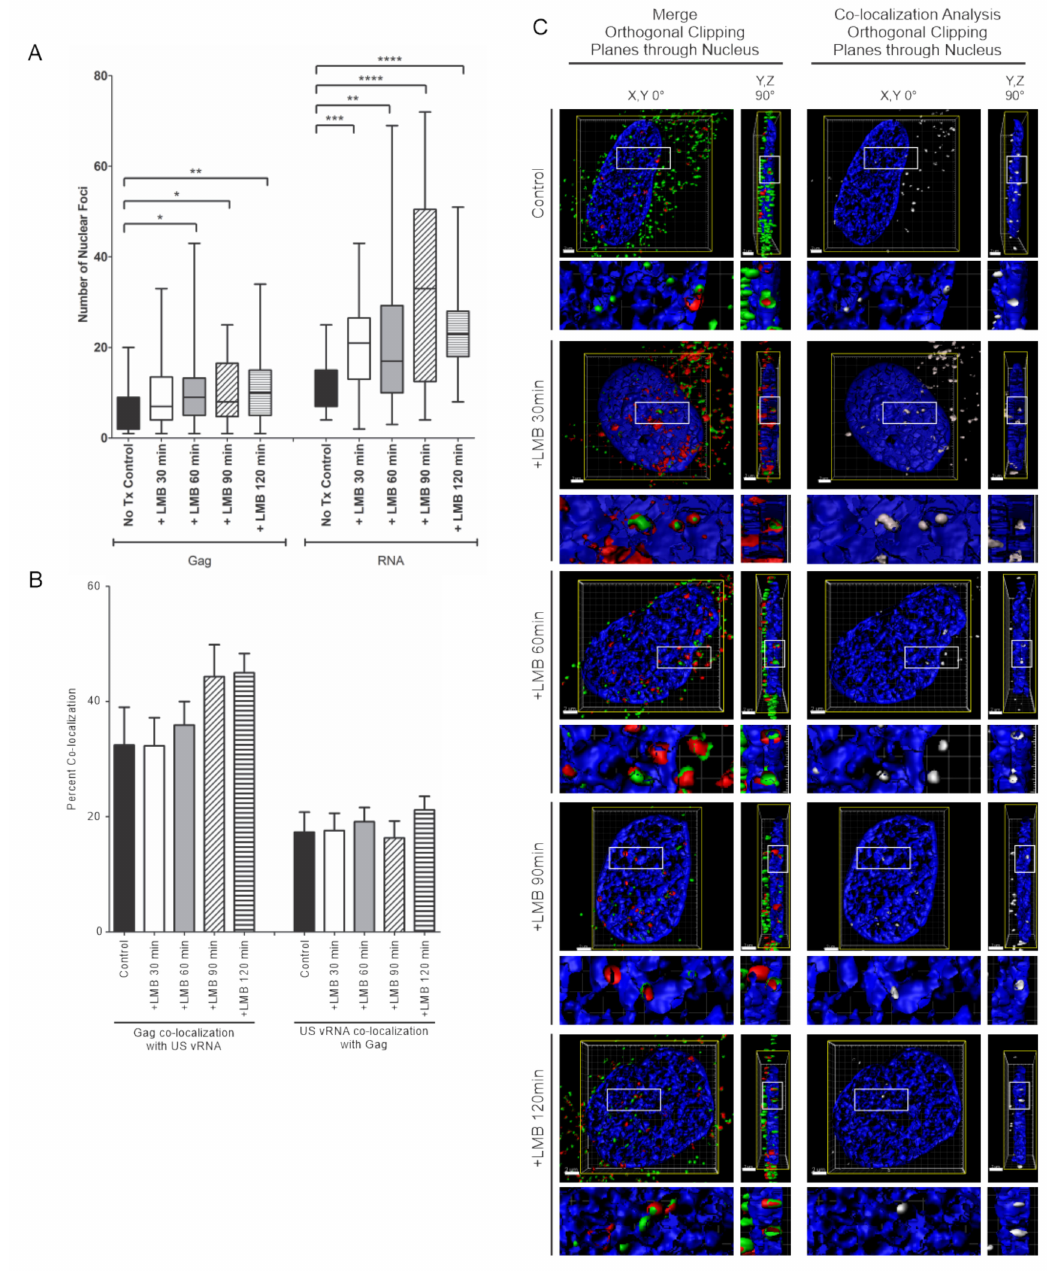
Figure 6. Inhibiting CRM1-mediated nuclear export in HeLa HIV.Gag-GFP rtTA cells increased HIV-1 Gag and USvRNA nuclear foci but did not a ff ect the degree of co-localization between HIV-1 Gag and USvRNA. ( A ) Quantitative analysis depicting the mean number of HIV-1 Gag-GFP and USvRNA nuclear foci in dox-induced HeLa HIV.Gag-GFP rtTA cells following LMB treatment compared to the untreated control cells. ( B ) Quantitative analysis of dox-induced HIV-1 Gag-GFP rtTA cells demonstrating the mean percent of nuclear HIV-1 Gag co-localization with USvRNA and USvRNA co-localization with HIV-1 Gag following treatment with LMB for 30, 60, 90, or 120 min prior to fixation compared to the untreated control. (error bars = standard error of the mean, statistical significances: * P < 0.05, ** P < 0.01, *** P < 0.001, **** P < 0.0001). ( C ) 3D surface renderings of dox-induced HeLa HIV.Gag-GFP rtTA cells depicting the co-localization (shown in white) of HIV-1 Gag-GFP (green) and USvRNA (red, detected by FISH) foci within the nucleus (DAPI, blue) following treatment with LMB. 3D surface renderings were subjected to an orthogonal clipping plane bisected in the X, Y and Y, Z planes to show the co-localization of foci within the nucleus. The white rectangle represents the region of interest enlarged in the panels